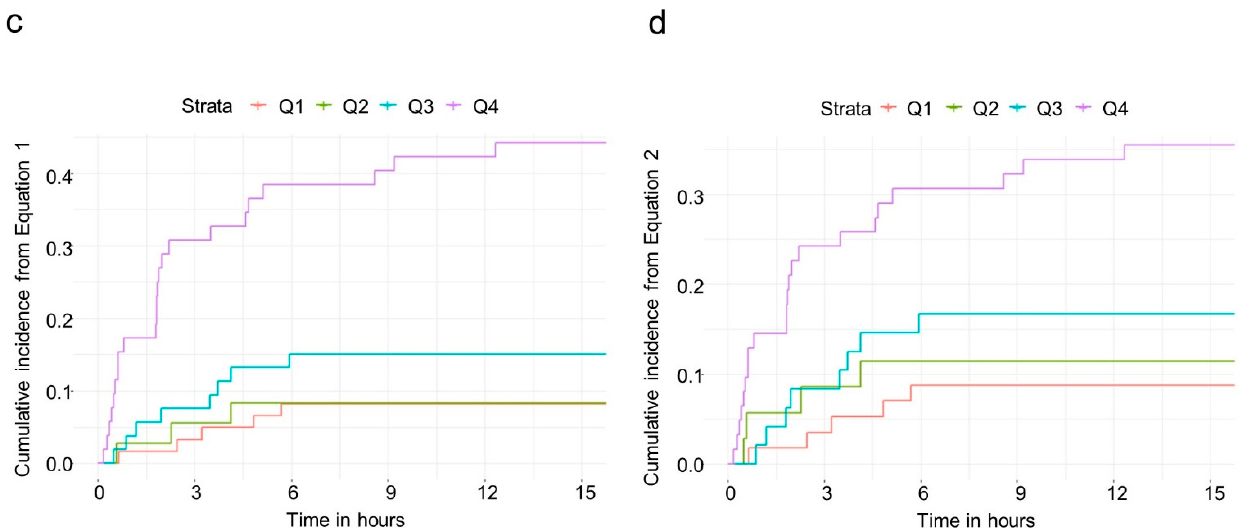
Figure 2. Predictive performance of equations in the validation cohort. ( a ) Receiver operating characteristic (ROC) curve analysis of both equations. ( b ) Frequency of early seizure recurrence in the emergency department (ES-RED) by quartiles in both Equations. ( c ) Cumulative incidence of ES-RED over time by quartiles in Equation (1). ( d ) Cumulative incidence of ES-RED over time.